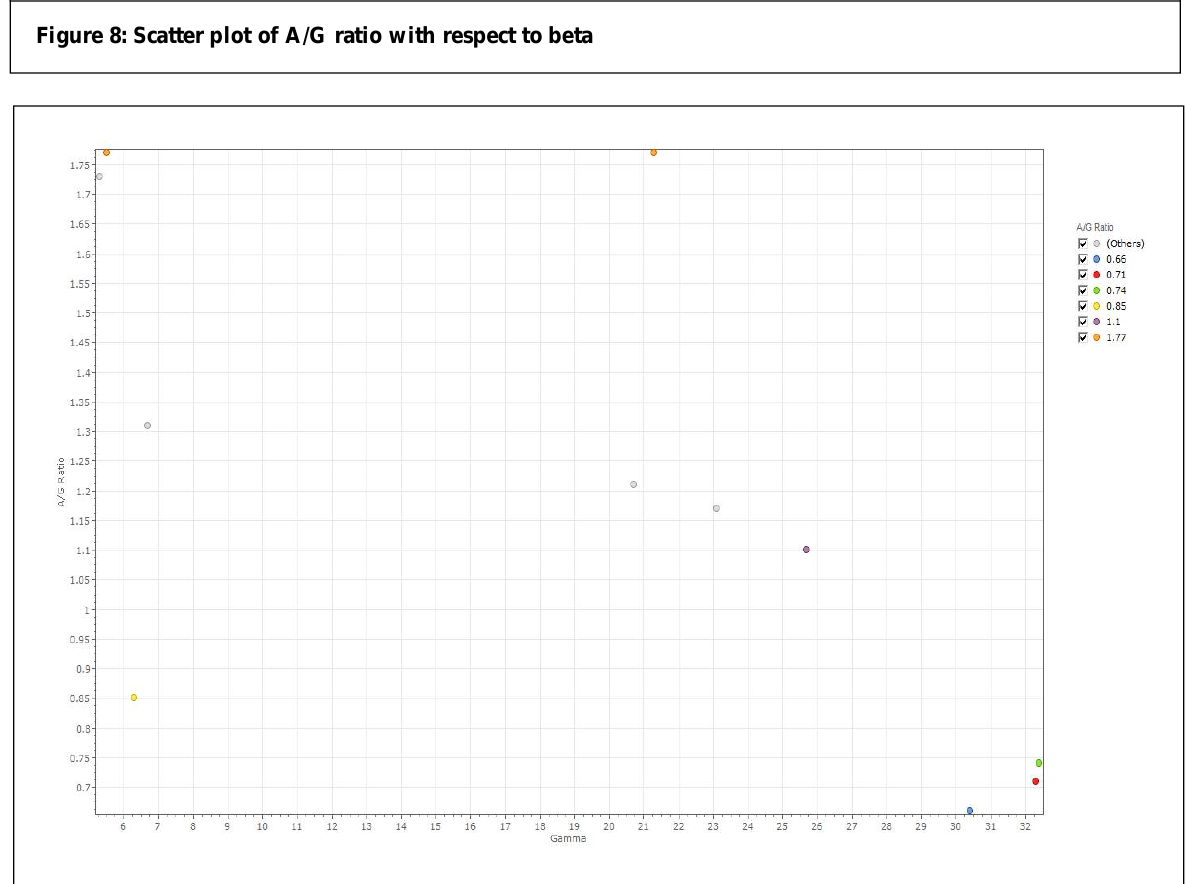
Figure 9: Scatter plot of A/G ratio with respect to